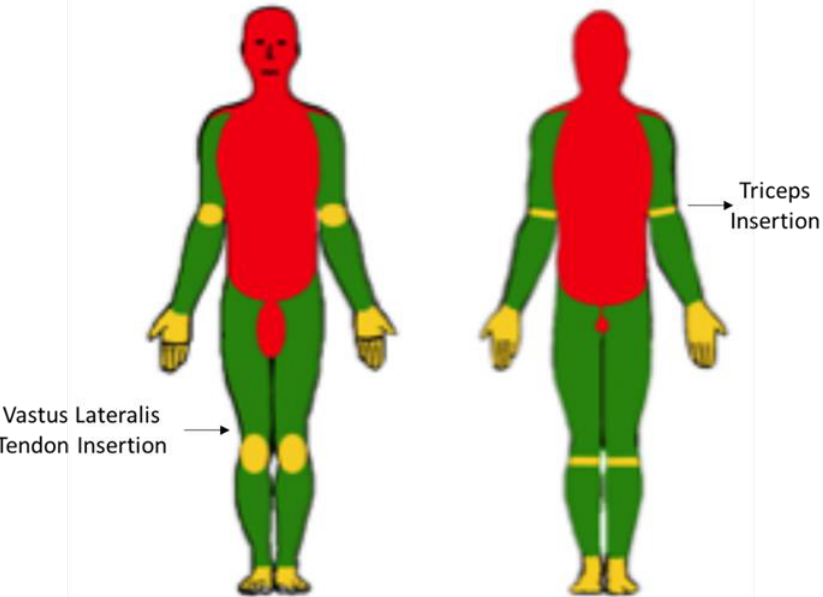
Figure 1. Zones of the human body hitting, handling or pressing of which can lead to variably serious damage. Red zone: points of high vulnerability (severe injury or death). Yellow zone: points of medium vulnerability (serious or permanent damage). Green zone: points of low vulnerability (no serious injury or permanent damage to be expected) [44].